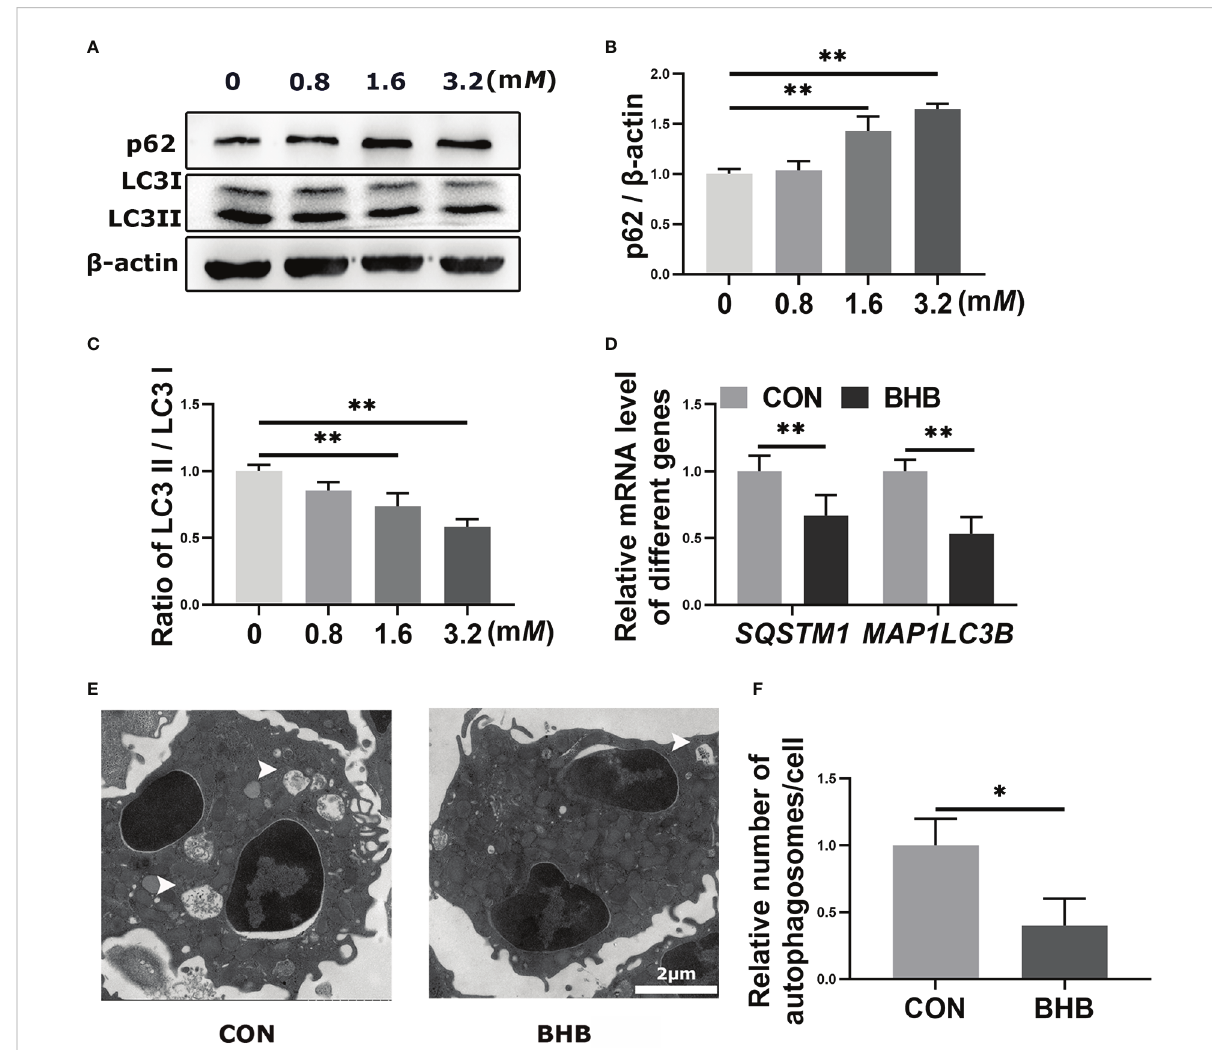
FIGURE 3 Effect of BHB on autophagy of bovine neutrophils. Neutrophils were treated with 0, 0.8, 1.6, and 3.2 m M BHB for 2 h, respectively. (A-C) Protein abundance of p62 and LC3. Representative blots in both groups were shown in A. The quanti fi cation was shown in B-C. Neutrophils were treated with 1.6 m M BHB for 2 h (D) mRNA abundance of SQSTM1 and MAP1LC3B . (E) Representative TEM images showing the autophagosomes in neutrophils. The autophagosomes were labeled by arrowheads. Magni fi cation, 2000× and Scale bars = 2 m m. (F) Relative average number of autophagosomes per cell. Autophagosomes were counted from at least 5 random complete views of cells in each sample and expressed as the number of autophagosomes per cell. For WB experiments, b -actin was used to normalize the total protein abundance. For qRT-PCR experiments, b -Actin and YWHAZ were used to normalize mRNA abundance. Data were expressed as the mean ± SEM. Data were analyzed with a one-way ANOVA with subsequent Bonferroni correction or independent-samples t-tests. ** P < 0.01 as statistically highly signi fi cant. BHB, b -hydroxybutyrate; p62, sequestosome-1; LC3, microtubule associated proteins 1A/1B light chain 3; SQSTM1 , sequestosome-1 ; MAP1LC3B , microtubule associated protein 1 light chain 3 beta ; YWHAZ , tyrosine 3-monooxygenase/tryptophan 5-monooxygenase activation protein zeta ; SEM, standard error of the